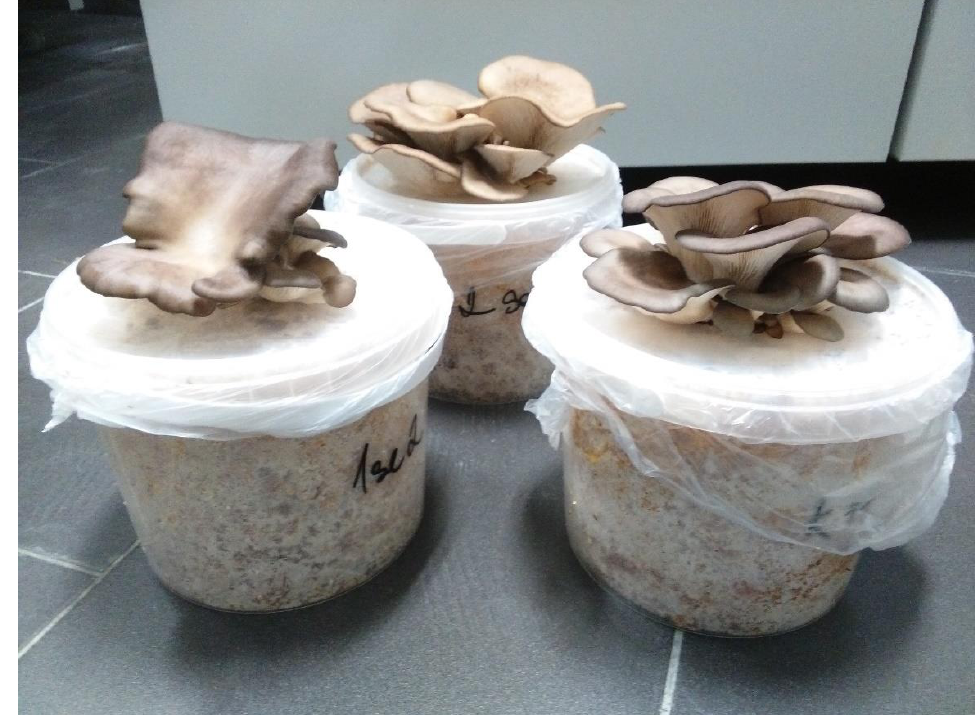
Figure 2. Fruiting body of Pleurotus ostreatus (Source: Author of the work).